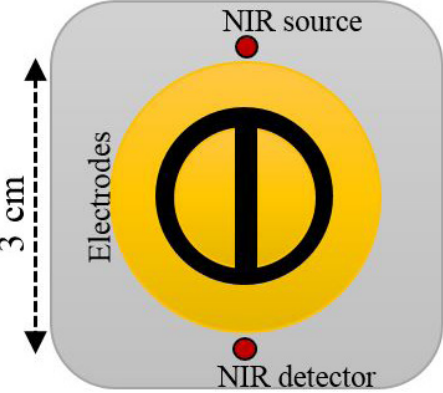
Fig. 1. Illustration of the sensor. It includes an optode con- sisting of a ¯ber optic near-infrared (NIR) light source at a distance of 3 cm from the ¯ber optic detector, both with a ¯ber thickness of 2.5 mm; a built-in 3D ACM and two copper elec- trodes with a ground plate placed between the optode. Thus, NIRS and sEMG measured the average activity of the muscle from approximately the same area. This noncommercial sEMG sensor prototype was produced by